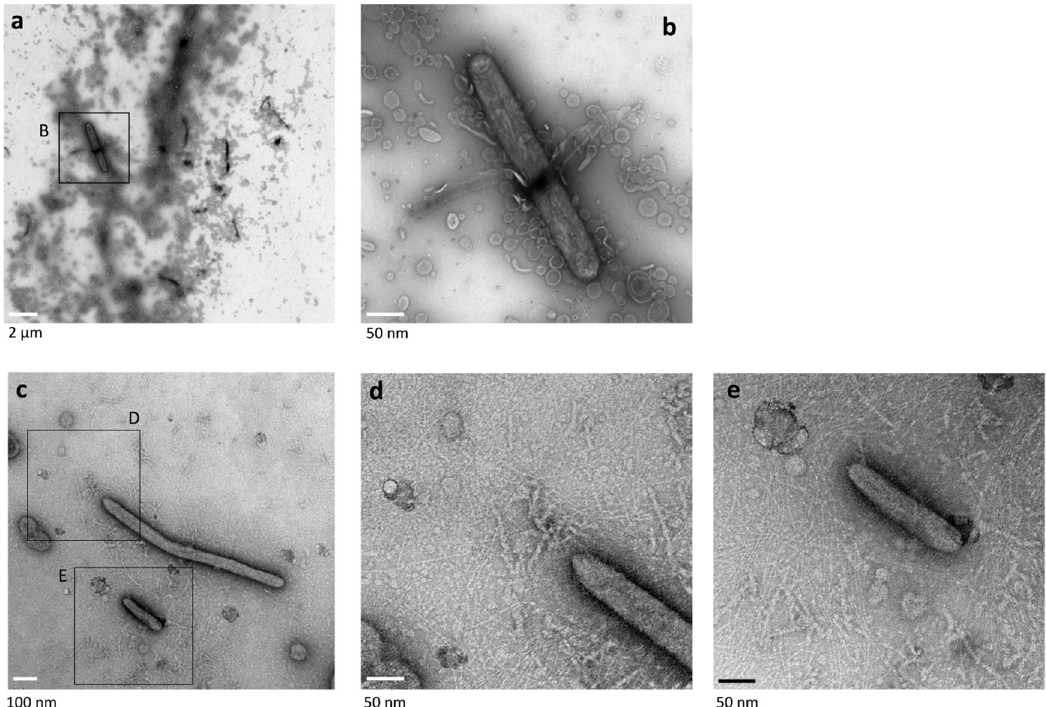
Figure 5. Colony surface inside the edge of a typical sprB colony imaged using the grid stamp method. ( a ) Low magnification image. ( b ) High magnification image (4.7 × ) of the annotated square in ( a ). ( c ) Medium magnification image of another area. ( d , e ) High magnification images (3 × ) of the annotated squares in ( c ). Just a small number of cells were observed, but most areas were occupied by thin extracellular fibers and vesicles. The vesicles had various shapes and sizes: small vesicles <30 nm, medium-sized vesicles (~ 30 nm), and a limited number of larger circular vesicles (150–200 nm in diameter).